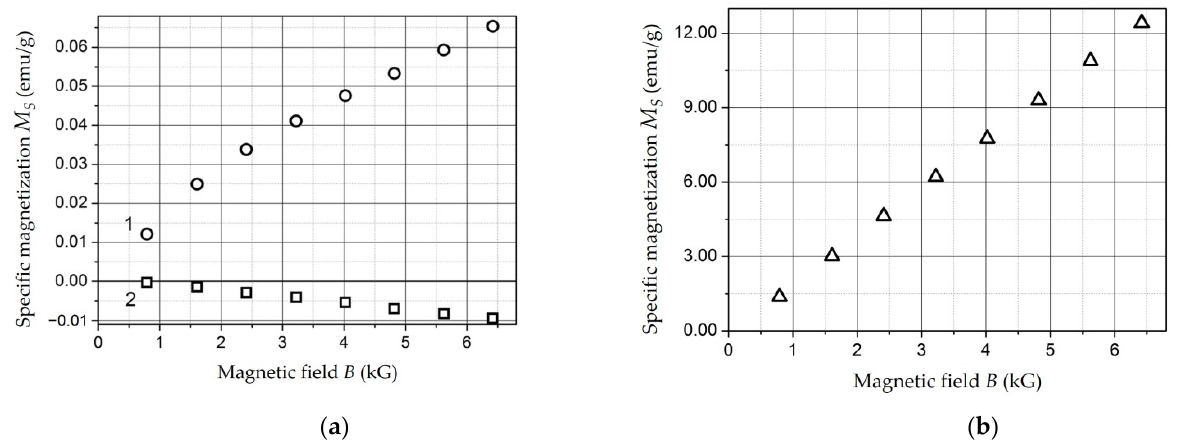
Figure 25. Magnetization curves of test samples: ( a ) Al , curve 1 (circles); Zn , curve 2 (squares); ( b ) Ho 2 Ti 2 O 7 . Table 9. Magnetic susceptibility of test samples.